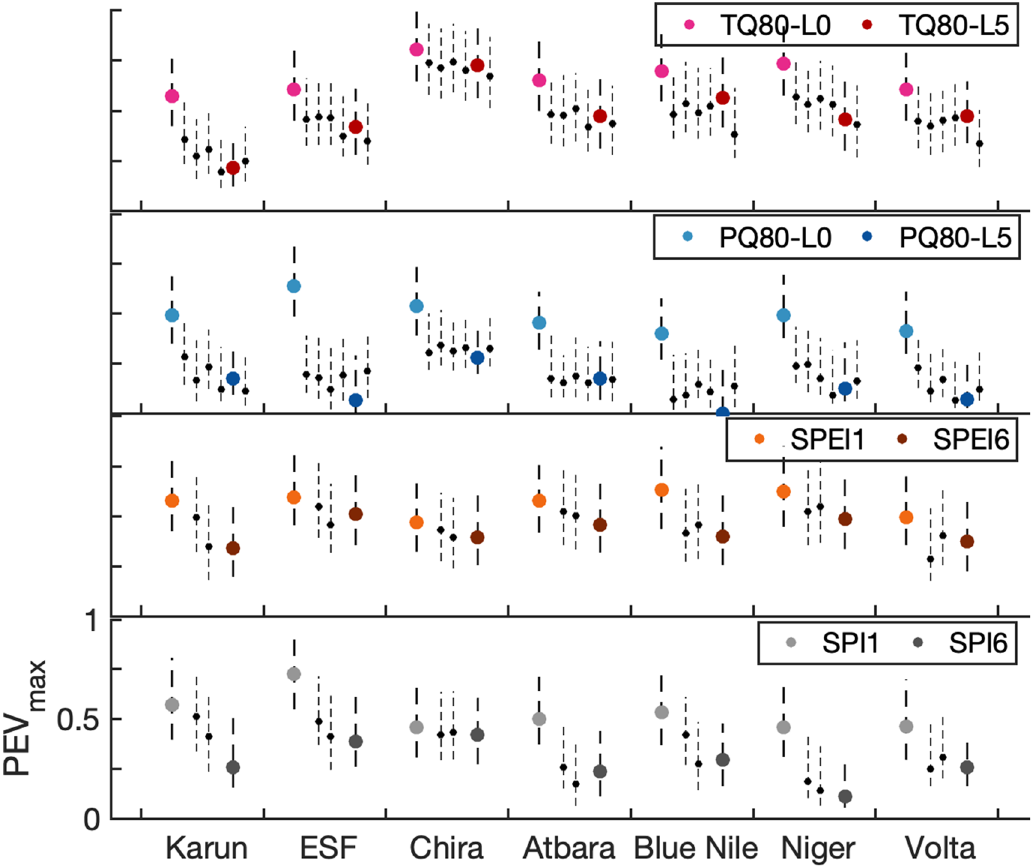
Figure 6. Maximum potential economic value for forecast-based action. PEV max of SEAS5 with reference ERA5 is shown for the seven river basins for rainy seasons of the hindcast period 1981-2016. Colored dots represent the fully evaluated PEV max for the events of T > Q 80 and P > Q 80 for leadmonths 0 (L0) and 5 (L5), and for the events SPEI < − 1 and SPI < − 1 for aggregation scales over one (SPI1/SPEI1) and 6 months (SPI6/ SPEI6). The uncertainty of the estimation of PEV max is assessed with the confidence range between the 10% and 90% quantiles of bootstrap resampling (dashed line). PEV max is also given for temperature and precipitation of leadmonths 1-4 and 6, and for drought events of scales over 3 and 4 months (black dots) with respective bootstrap confidence